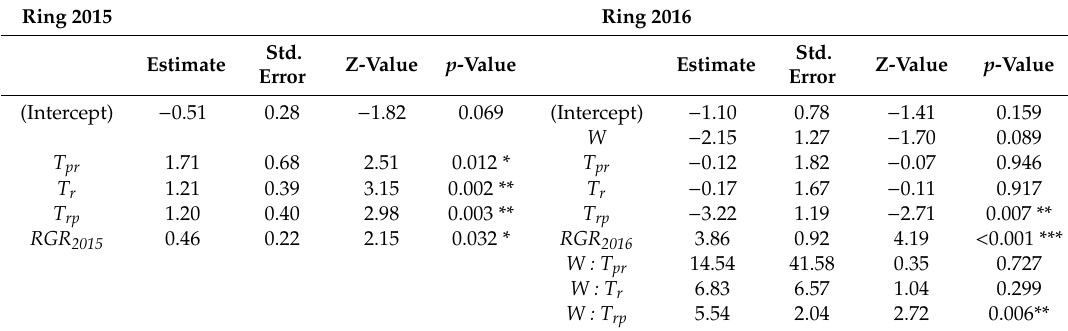
Table 6. Statistics from the logistic regression models with the absence / presence of dendritic patterns (flame-like structures of grouped latewood vessels) in the secondary xylem in 2015 and 2016 as response variables. The standard level of the categorical variable taxon of the mother tree ( T ) was Q. petraea , to which the other taxa were compared with. T pr : long stalked intermediate form, T r : Q. robur , T rp : short-stalked intermediate form. RGR 2015 and RGR 2016 : relative growth rate of height in 2015 and 2016, respectively.